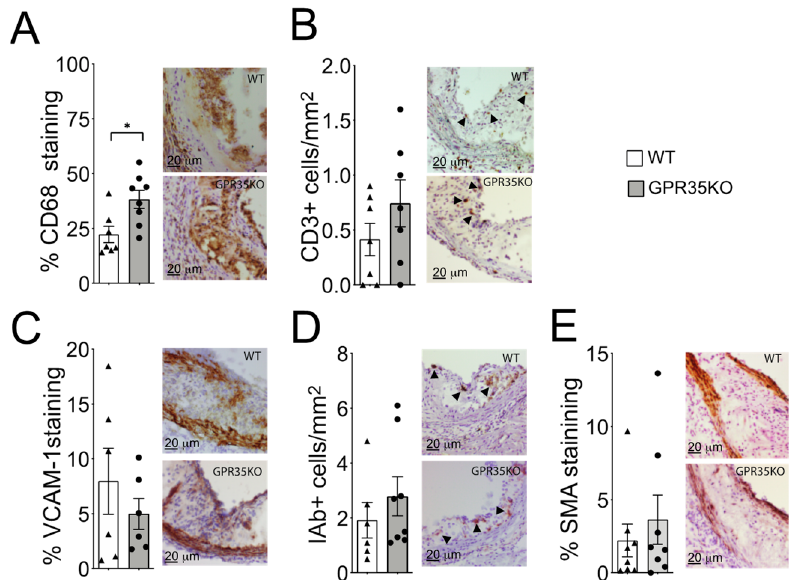
Figure 3. Effects of GPR35KO reconstitution on plaque inflammatory cell composition. Thirteen week-old LdlrKO mice reconstituted with GPR35KO or WT mice bone marrows were fed WD for 8 weeks. ( A ) Percentage of CD68+ macrophages, ( B ) number of CD3+ T cells/mm 2 , ( C ) percentage of VCAM-1+ stained cells, ( D ) the number of IA b + cells/mm 2 , and ( E ) the percentage of α -smooth muscle cell actin (SMA) in both groups. Right panels show representative micrographs for each group. Results are mean ± SEM; n = 7-8. Mann–Whitney was used detect statistical differences. (*) p < 0.05.